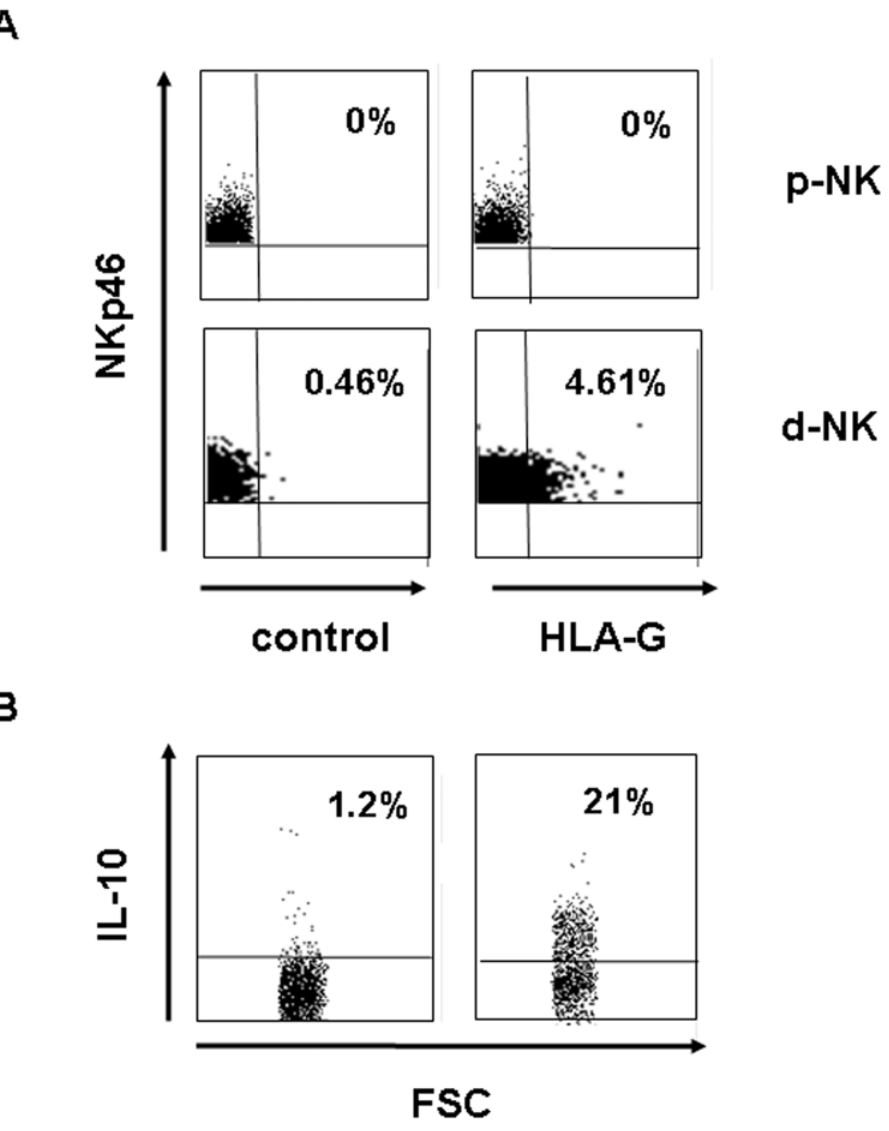
Figure 10. Invivo detection in freshly isolated decidual NK cells of a NKp46 + HLA-G + IL-10 + subset. (A) Dot plot analysis of expression of NKp46 and HLA-G (surface labeling) in human freshly isolated decidual (d-NK) and PB-derived NK cells from pregnant woman (p-NK). Data are representative of six independent experiments. (B) Expression of IL-10 (internal labeling) was analyzed on the gated positive NKp46 + HLA-G + NK cell